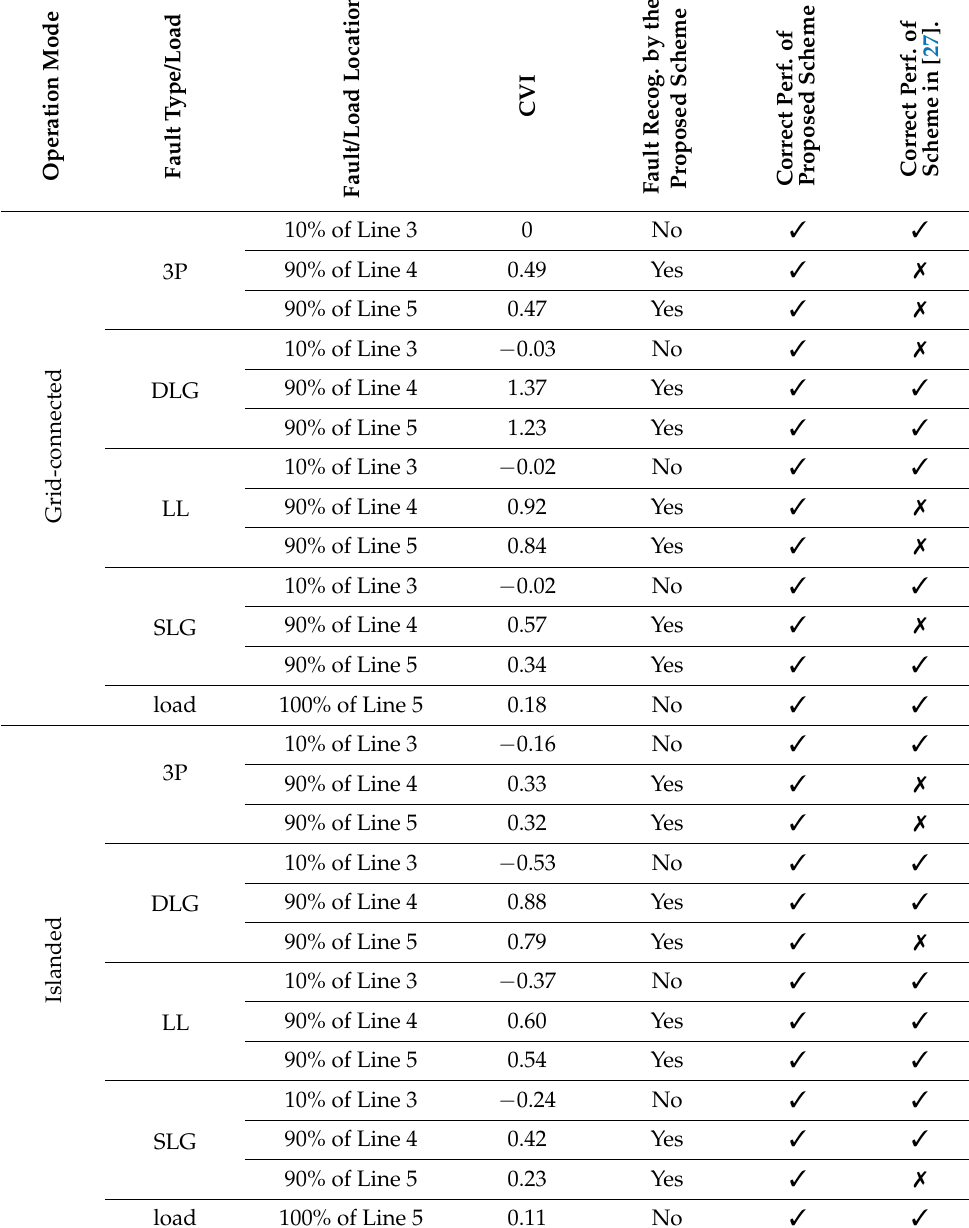
Table 8. Backup protection performance in pre-fault conditions